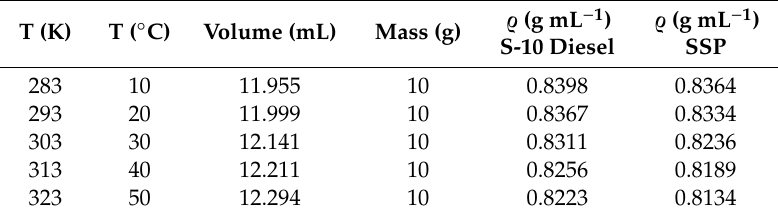
Table 5. Density of SSP at di ff erent temperatures.